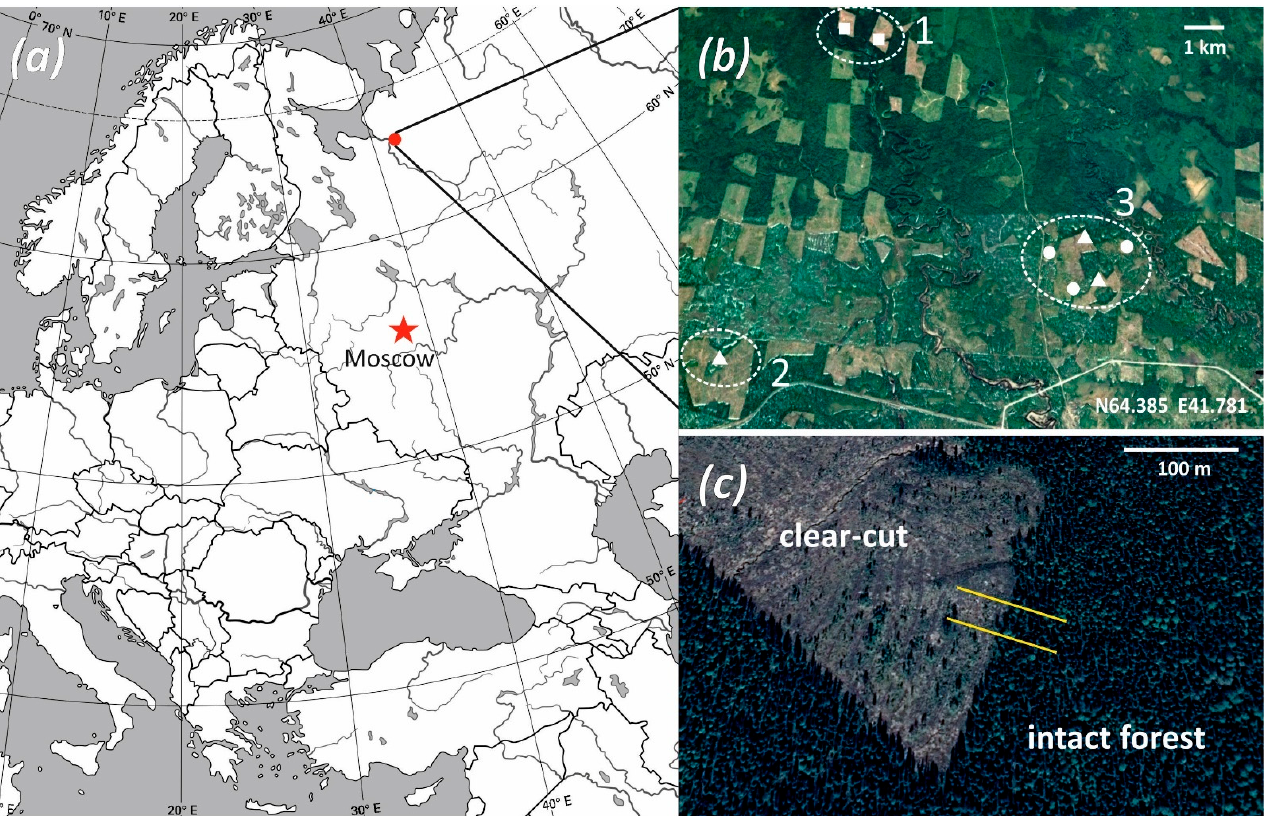
Figure 1. Locations of sampling sites and transect layout. ( a )—location of the study area; ( b )—locations of clear-cuts (numerals denote sampling site numbers, square marks a 2-year-old clear-cut, triangle—a 5-year-old clear-cut, and circle—a 10-year-old clear-cut, dash line outlines sampling sites; ( c )—layout of transects (yellow lines) perpendicular to the forest/clear-cut edge.